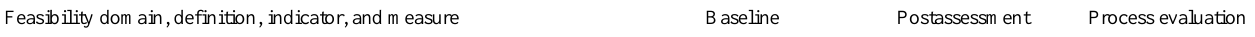
Demand: extent to which the intervention is likely to be used Organizational adoption